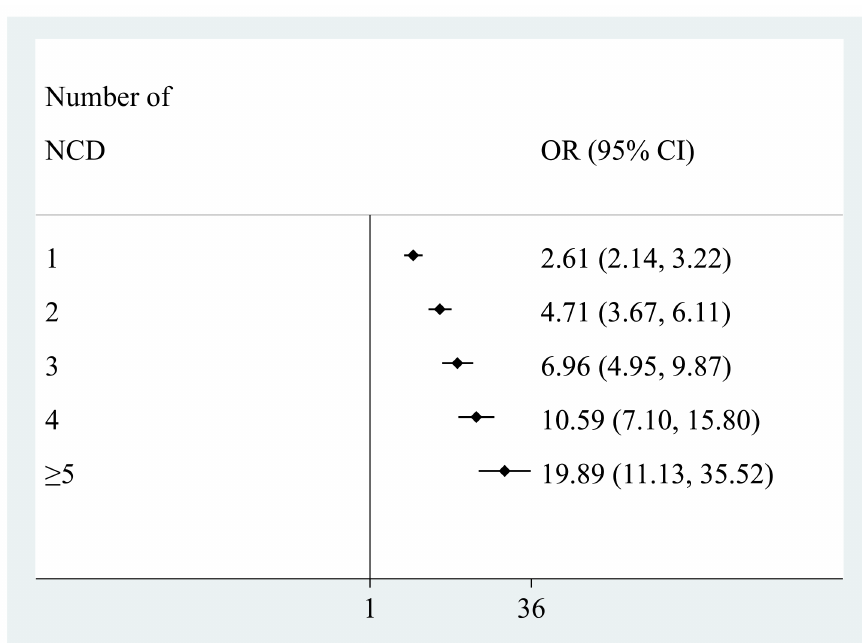
Figure 2. Association between number of non-communicable diseases and tuberculosis, estimated by multivariable logistic regression. Abbreviation: NCD Non-communicable disease; OR Odds ratio; CI Confidence interval. Reference category is no non-communicable disease. Model is adjusted for age, sex, wealth, education, smoking, heavy drinking, and country.